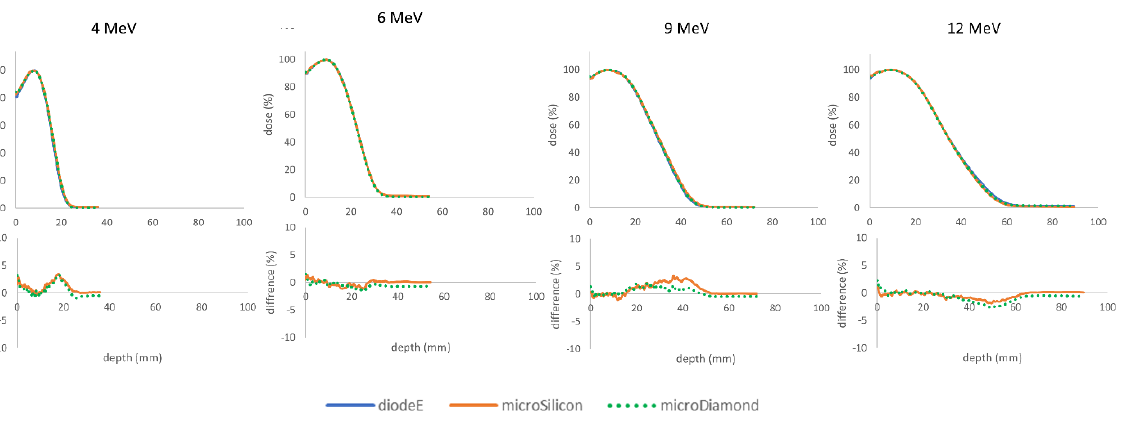
Figure 2. PDD curves measured for the 20 mm diameter field with the solid-state detectors: % differences between microSilicon and microDiamond data, and diode E reference measurements were also shown. Table 1. Maximum difference in distance (mm), within the 20-80% PDD region for the solid-state detectors (diode E reported as d-E, microDiamond as m-D and microSilicon as m-Si), with respect to the chosen reference for each beam energy. The mean value over all beam energies was also shown. Table 2. Most relevant dosimetric parameters, extracted from PDD curves for the 50 mm diameter field, measured by ionization chamber Markus (M), diode E (d-E), microDiamond (m-D), and microSilicon